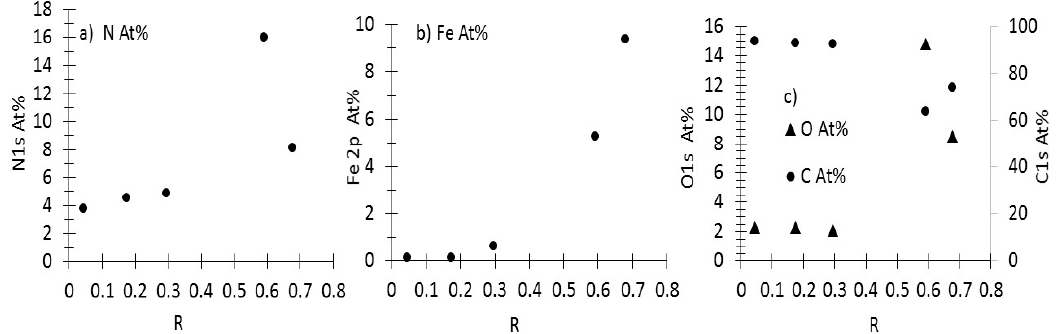
Figure 9. Trends for the XPS semi-quantitative analysis for powders obtained from LMP-2 as a function of R parameter. ( a ) N1s; ( b ) Fe2p; ( c ) O1s and C1s.